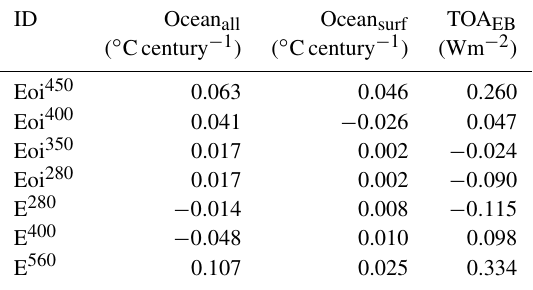
Table 2. Summary of equilibrium state metrics for the seven PlioMIP2 protocol experiments. Globally integrated (Ocean all ) and surface ocean (top 200m; Ocean surf ) climatological trends and top- of-the-atmosphere energy balance (TOA EB ) are derived from the last 100 model